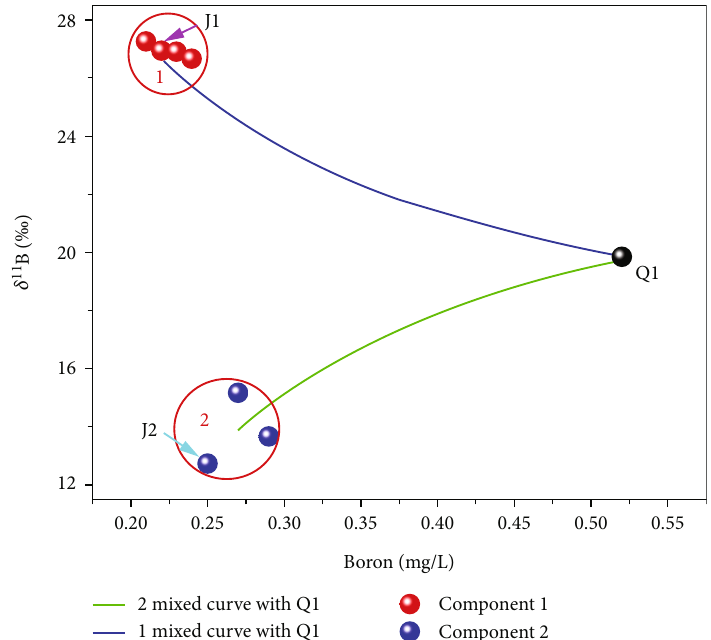
22 mixed curve with Q1 1 mixed curve with Q1 Component Figure 9: Relationship between the basin water samples and the boron isotopic composition (the mixing curves of 1, 2, and Q1 were calculated according to the mixing Equation